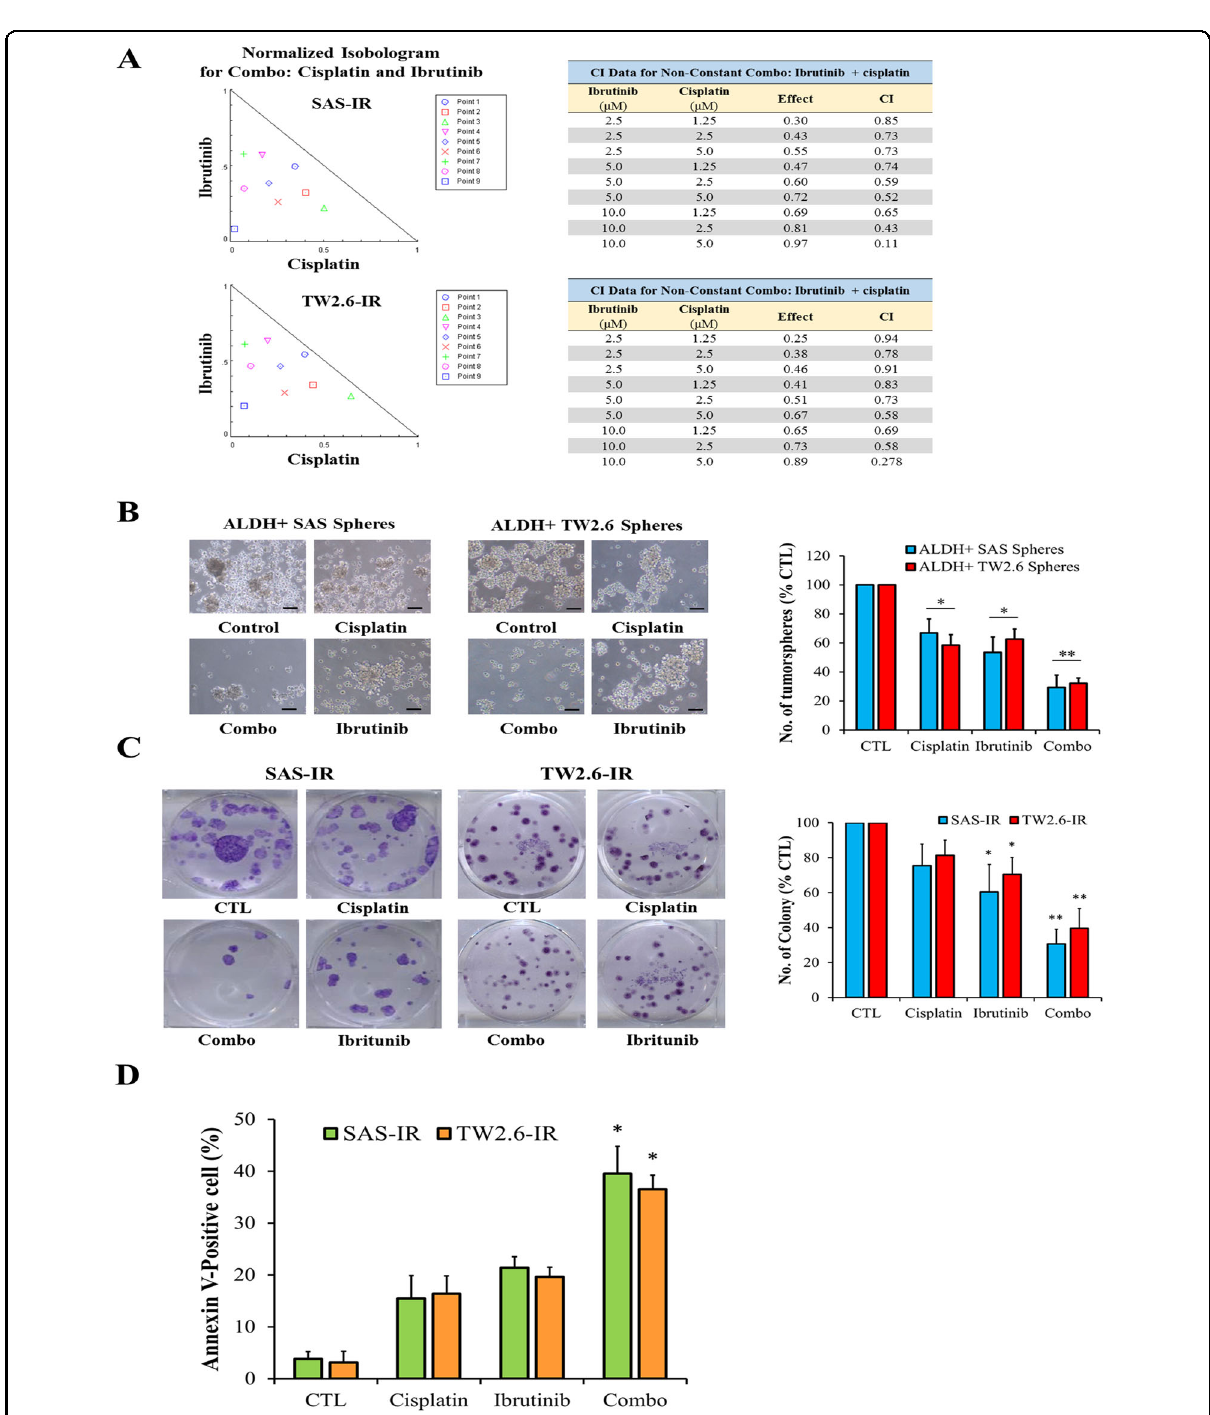
Fig. 5 Ibrutinib reduced cisplatin-induced oral CSCs enrichment, increases apoptosis, limits the colony-forming potential, and enhances the sensitivity of the ALDH + OSCC cells to cisplatin. A Drug combination assay: different concentrations of ibrutinib and cisplatin were used in combination for calculating the combination index (CI). Normalized isobolograms demonstrated that ibrutinib and cisplatin synergistically suppressed the cell viability of OSCC spheres. CI < 1 denotes synergy. B Photo images ( left ) and graphical quantitative data ( right ) of the tumorsphere- forming ability of the ALDH + SAS or TW2.6 cells after treatment with 5 μ M cisplatin, 5 μ M ibrutinib, or both compared with control cells. C Treatment of ibrutinib alone or in combination with cisplatin effectively reduces the colony-forming abilities, graphical quantitative data of the number of colonies formed by the SAS-IR or TW2.6-IR cells after treatment with 5 μ M cisplatin, 5 μ M ibrutinib, or both compared with control cells. D Apoptotic effect of cisplatin alone, ibrutinib alone, or cisplatin – ibrutinib combination treatment in SAS-IR or TW2.6-IR cells. Data represent experiments performed in triplicates and expressed as mean ± SD. * p < 0.05, ** p <